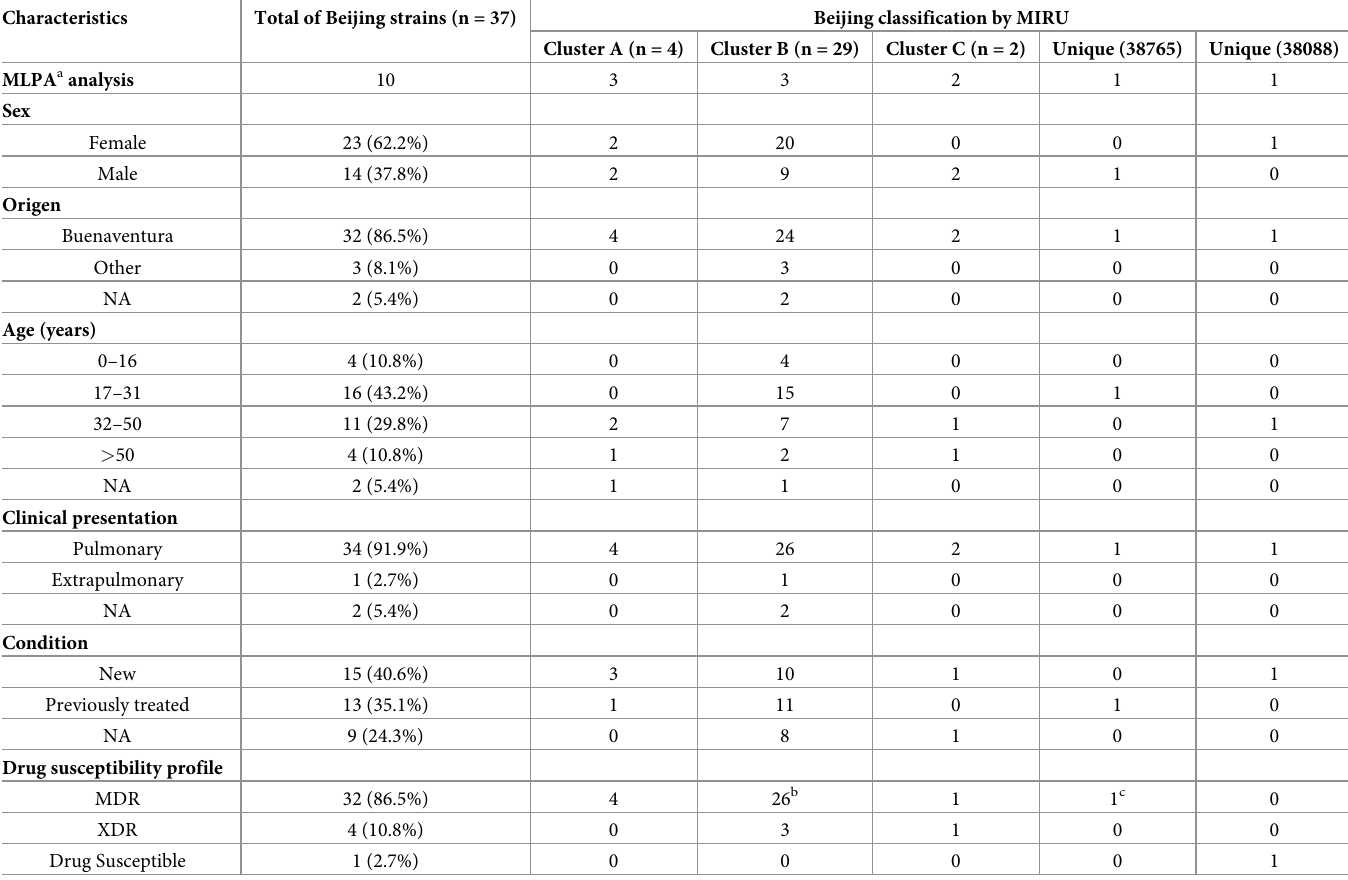
(Fig 2). The discriminatory power index of MIRU-VNTR 24 loci ( D = 0.3799) was superior Table 1. Characteristics of TB patients and 24-loci MIRU-VNTR Beijing